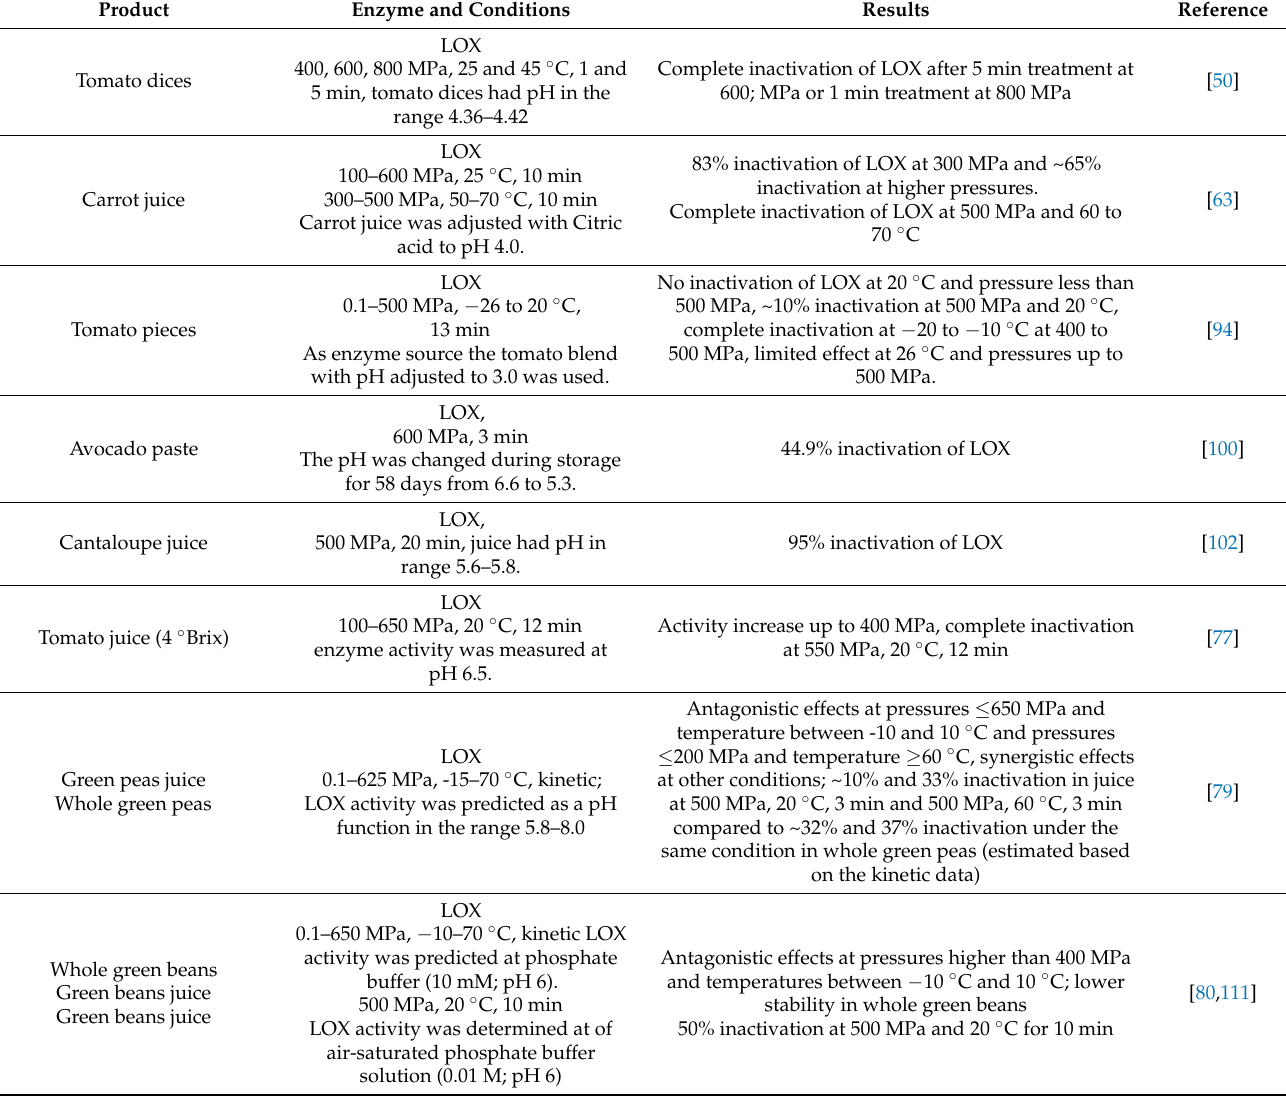
Table 5. Summary of relevant studies on the effect of HPP on flavor modifying